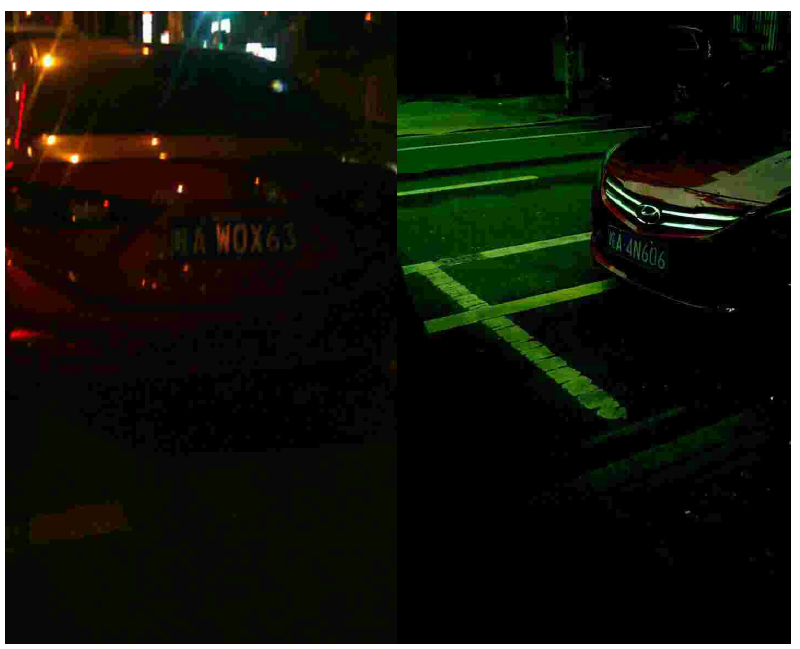
Figure 8. Examples of failure cases from the the CCPD dataset. In the first example, the low light leaves no clear outline of the plate. In the second example, the plate can be seen, but the lighting conditions render the color unrecognizable. In both cases, DeepLabv3+ fails to detect the